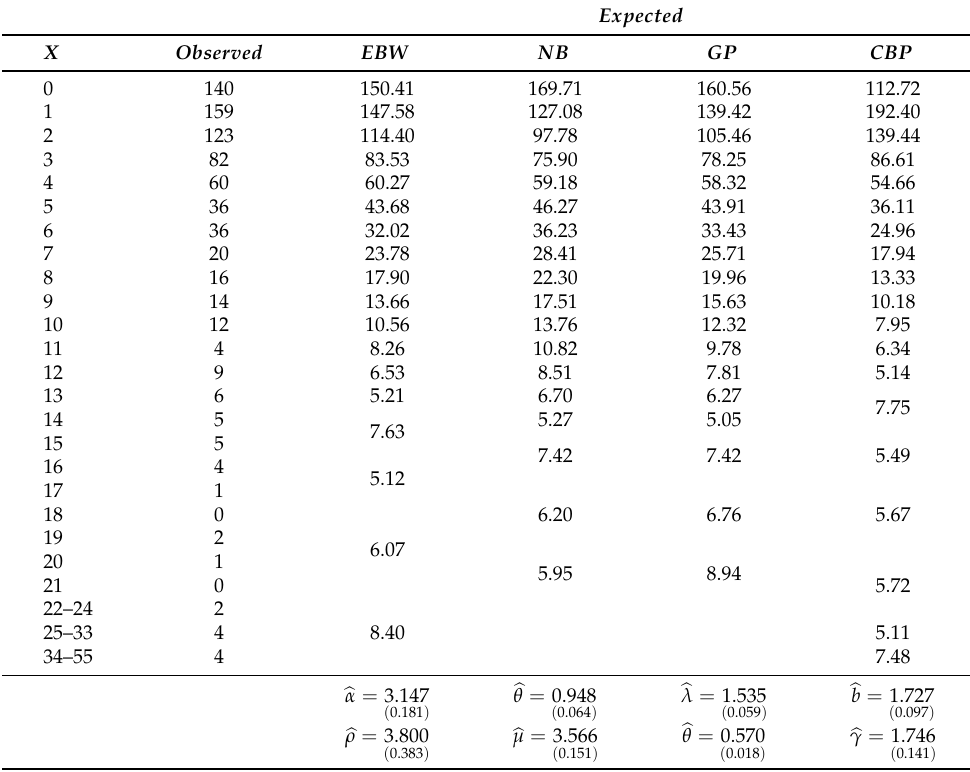
Figure 4. Observed and expected frequencies for data about other sports facilities (from 0 to 10). Table 6. Observed and expected frequencies for data about other sports